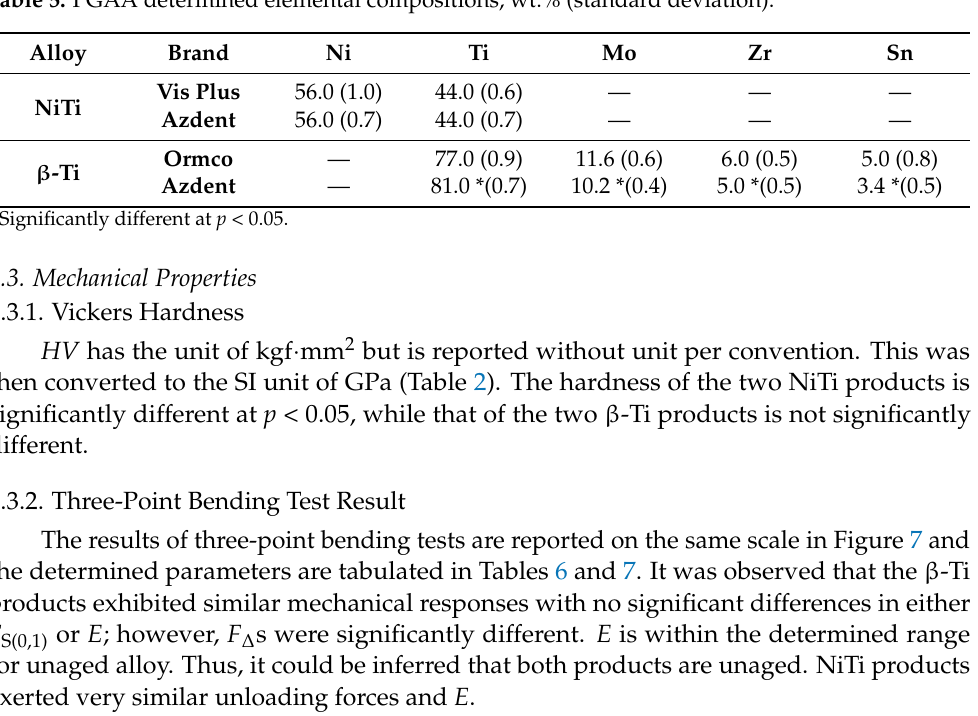
Table 5. PGAA determined elemental compositions, wt.% (standard deviation).